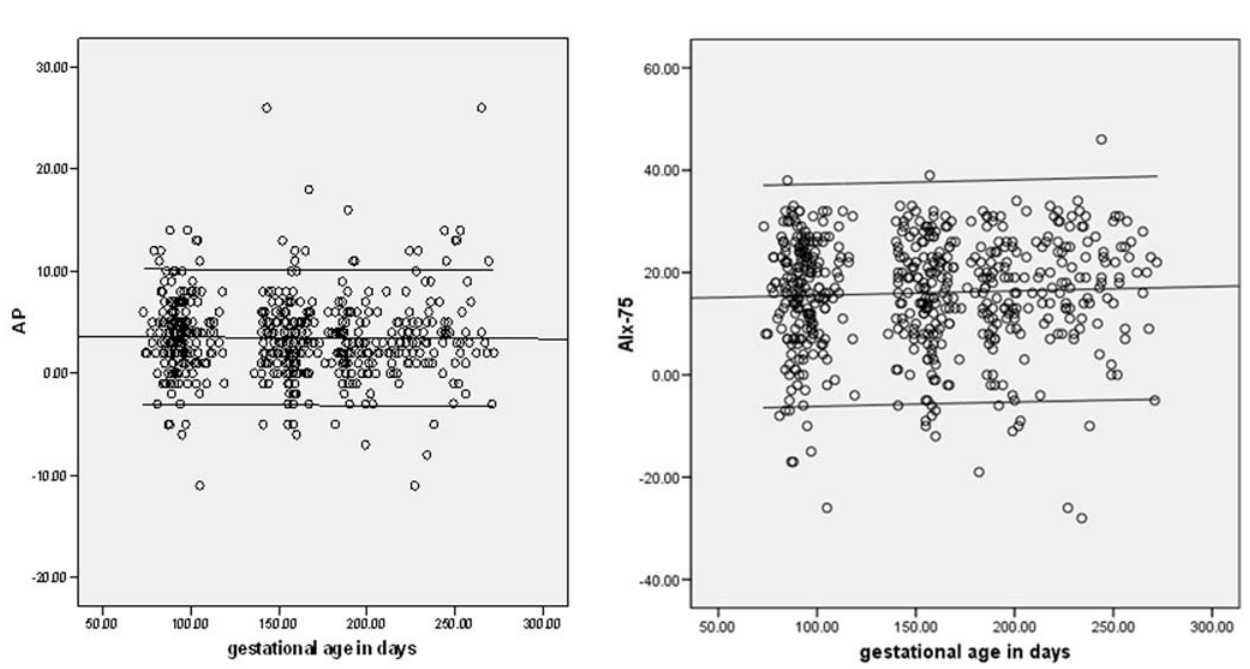
Figure 3. Pulse wave analysis parameters according to gestation. Scatter plots of (a) augmentation pressure (AP), and (b) augmentation index at heart rate of 75/min (AIx-75) according to the gestational age in days (n=541). The 5 th and 95 th centiles are shown. Only one measurement from each woman is included.